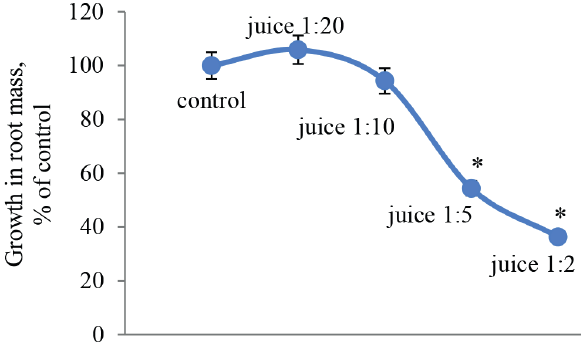
Figure 2 Mitotic index of root meristem cells after treatment with apple juice in different concentrations (n = 10). * P ≤